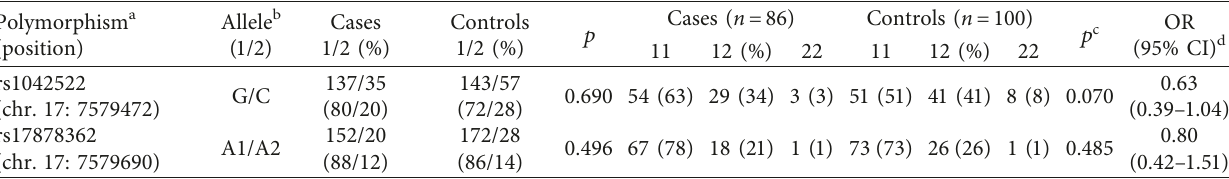
Table 1: Association analysis of two TP53 gene polymorphisms with keloid in